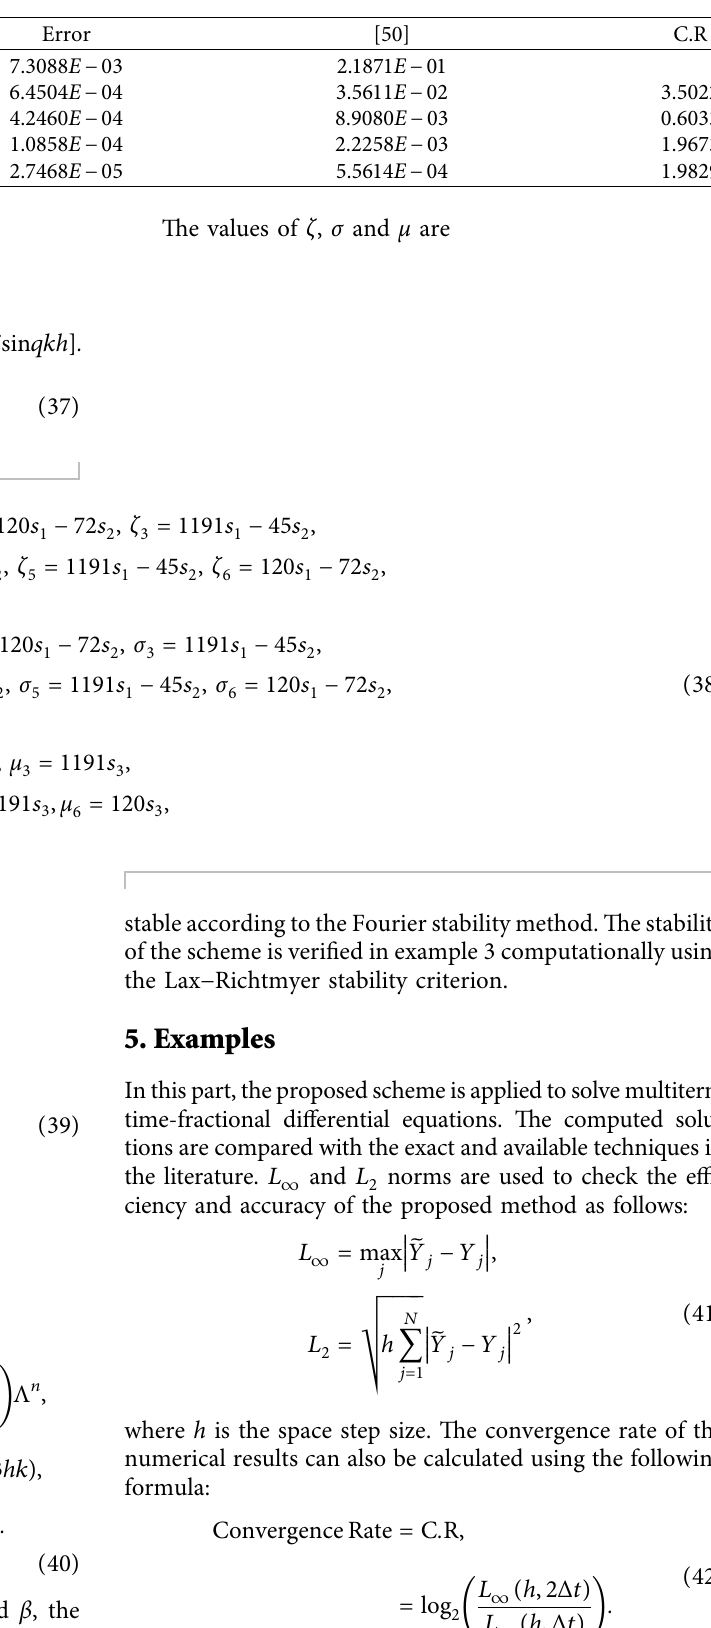
Table 4: Error norm of Y at diferent step